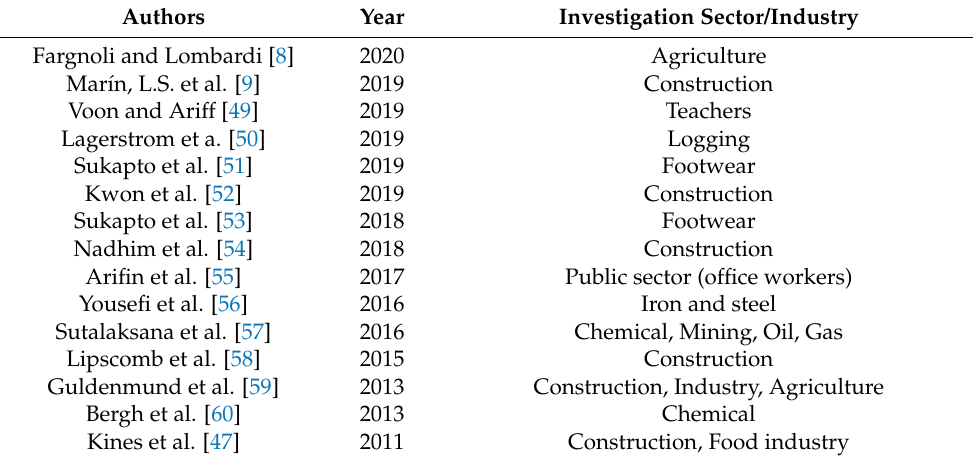
Table 2. Articles addressing the use of NOSACQ-50 (listed according to the publication